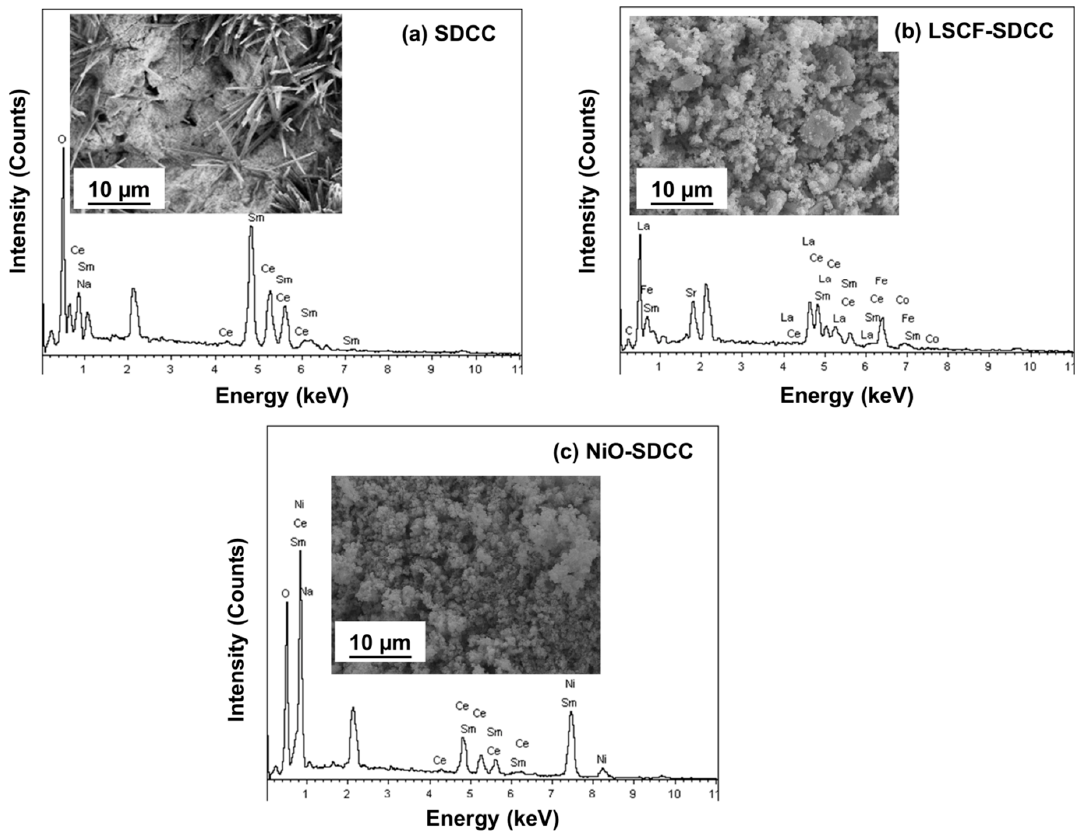
Figure 1. Energy-dispersive spectra and SEM images (insert) of ( a ) samarium doped ceria–carbonate (SDCC) electrolyte, ( b ) La 0.6 Sr 0.4 Co 0.2 Fe 0.8 O 3- δ /samarium-doped ceria-carbonate (LSCF–SDCC)